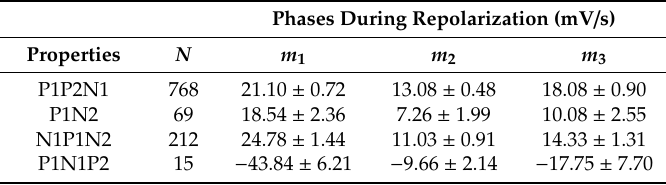
Table A5. Values for the first three phases of repolarization. Values as x ± SEM , except of N , which indicates the number of